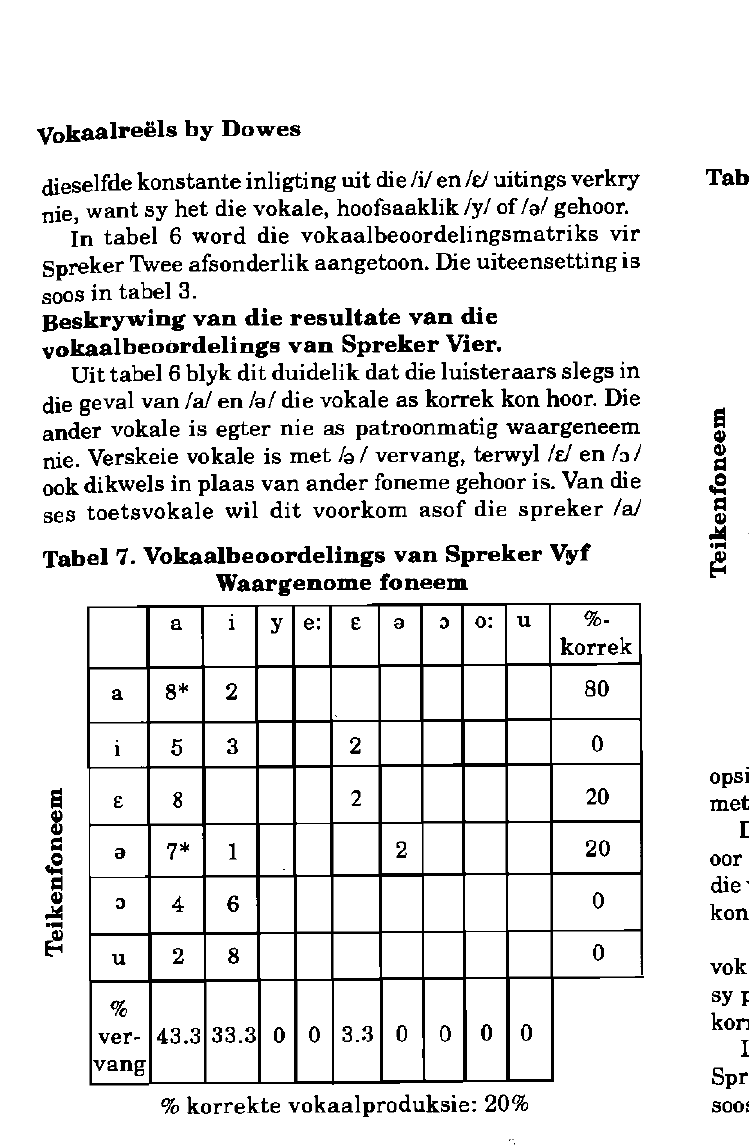
In tabel 7 word die vokaalbeoordelingsmatriks vir Spreker Twee afsonderlik aangetoon. Die uiteensetting is soos in tabel 3.